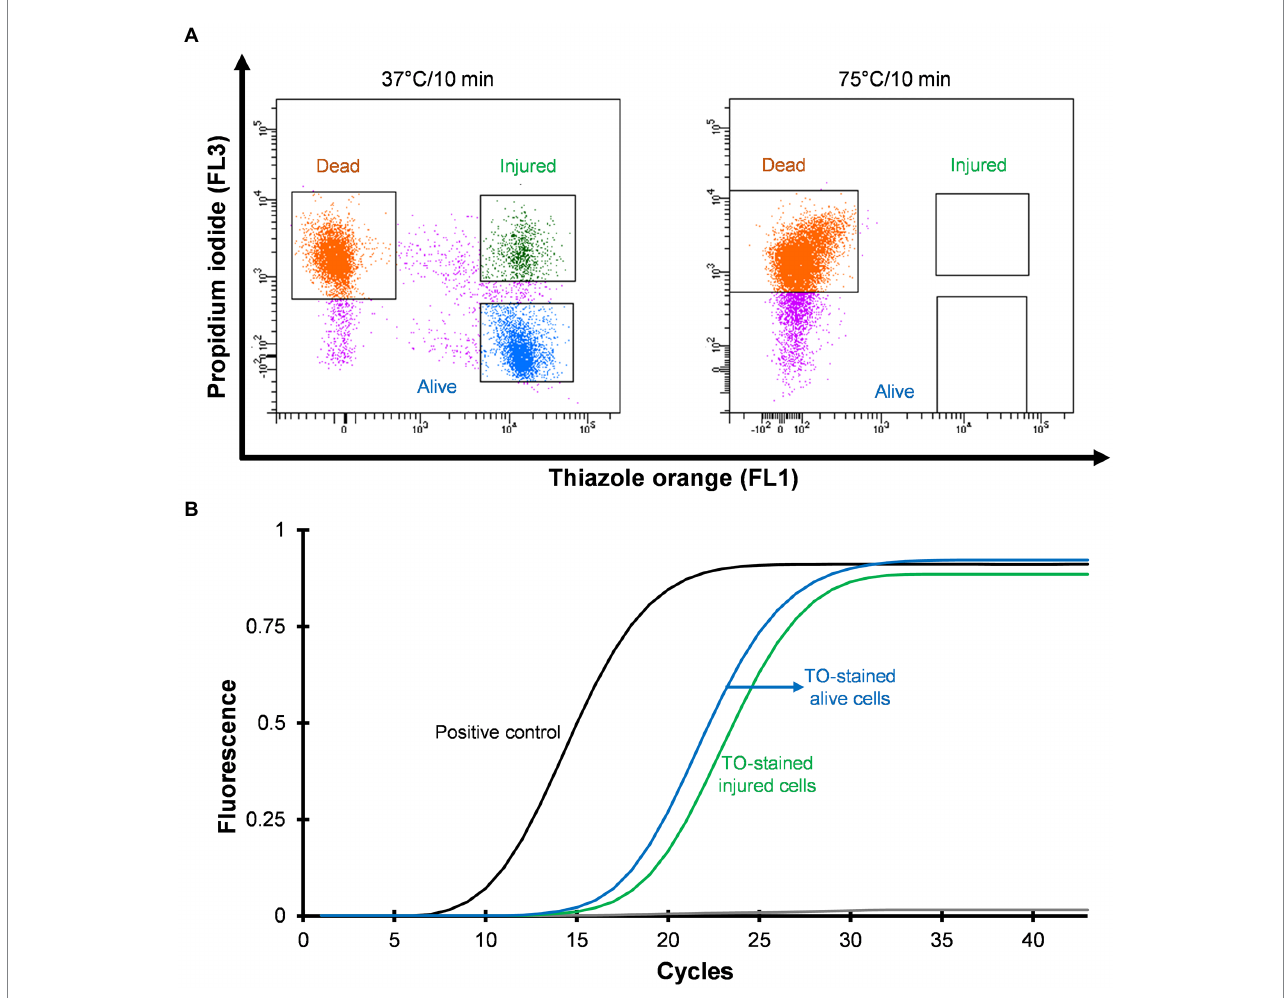
FIGURE 2 Viability based flow cytometry-cell sorting and qPCR assay. L. pneumophila grown on BCYE-GVPC agar at 37 ° C were used as a positive control and cells treated at 75 ° C for 10 min were used as a negative control. (A) Cytograms represent three populations: thiazole orange-stained alive (blue), thiazole orange- stained injured (green) and propidium iodide-stained dead (orange) cells. Propidium iodide selectively stained dead cells. Pink colored events are debris. (B) qPCR assay of thiazole orange stained alive and injured cells. The results showed that thiazole orange (TO) does not interfere with DNA extraction and